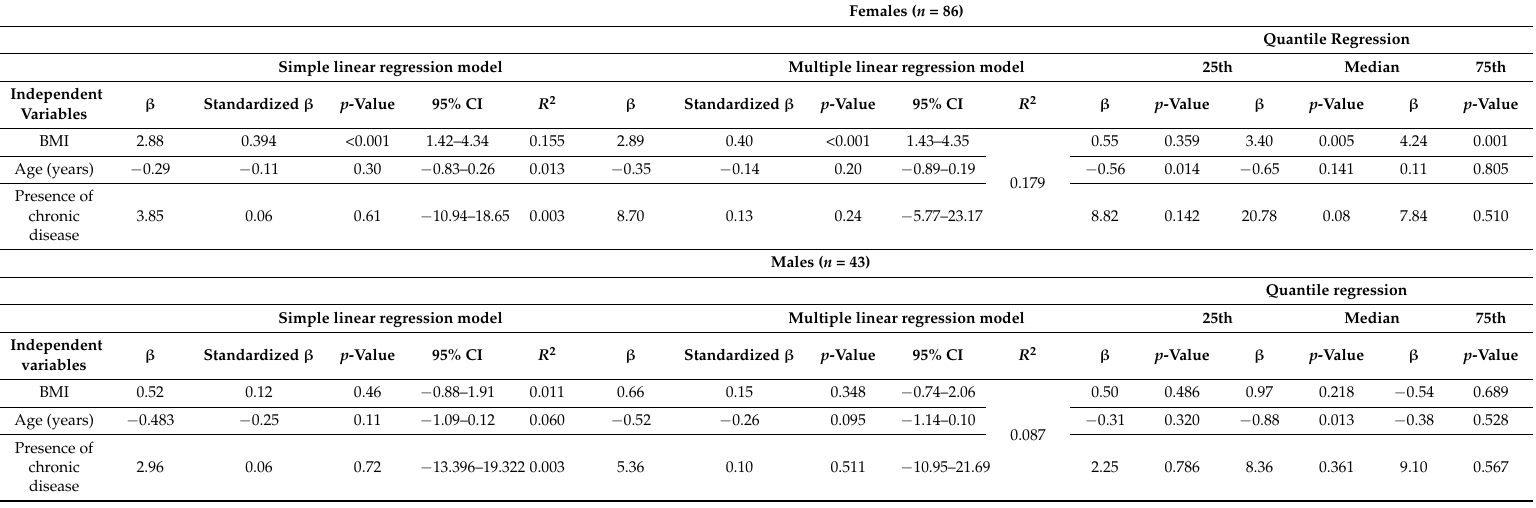
Table 2. Linear regression coefficients and 95% confidence intervals (CIs) for ORWELL 97 and among patients with obesity seeking treatment.